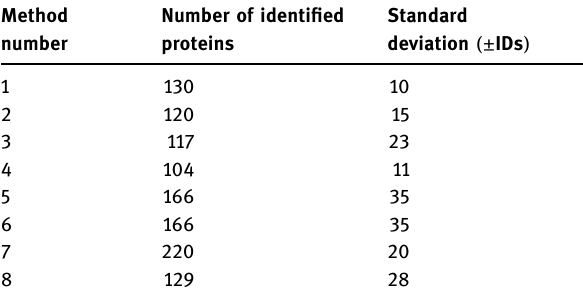
Table 4: Overview of the number of proteins identi fi ed in urine samples, depending on di ff erent extraction procedures ( sample description in Table 1 ) and the urine volume